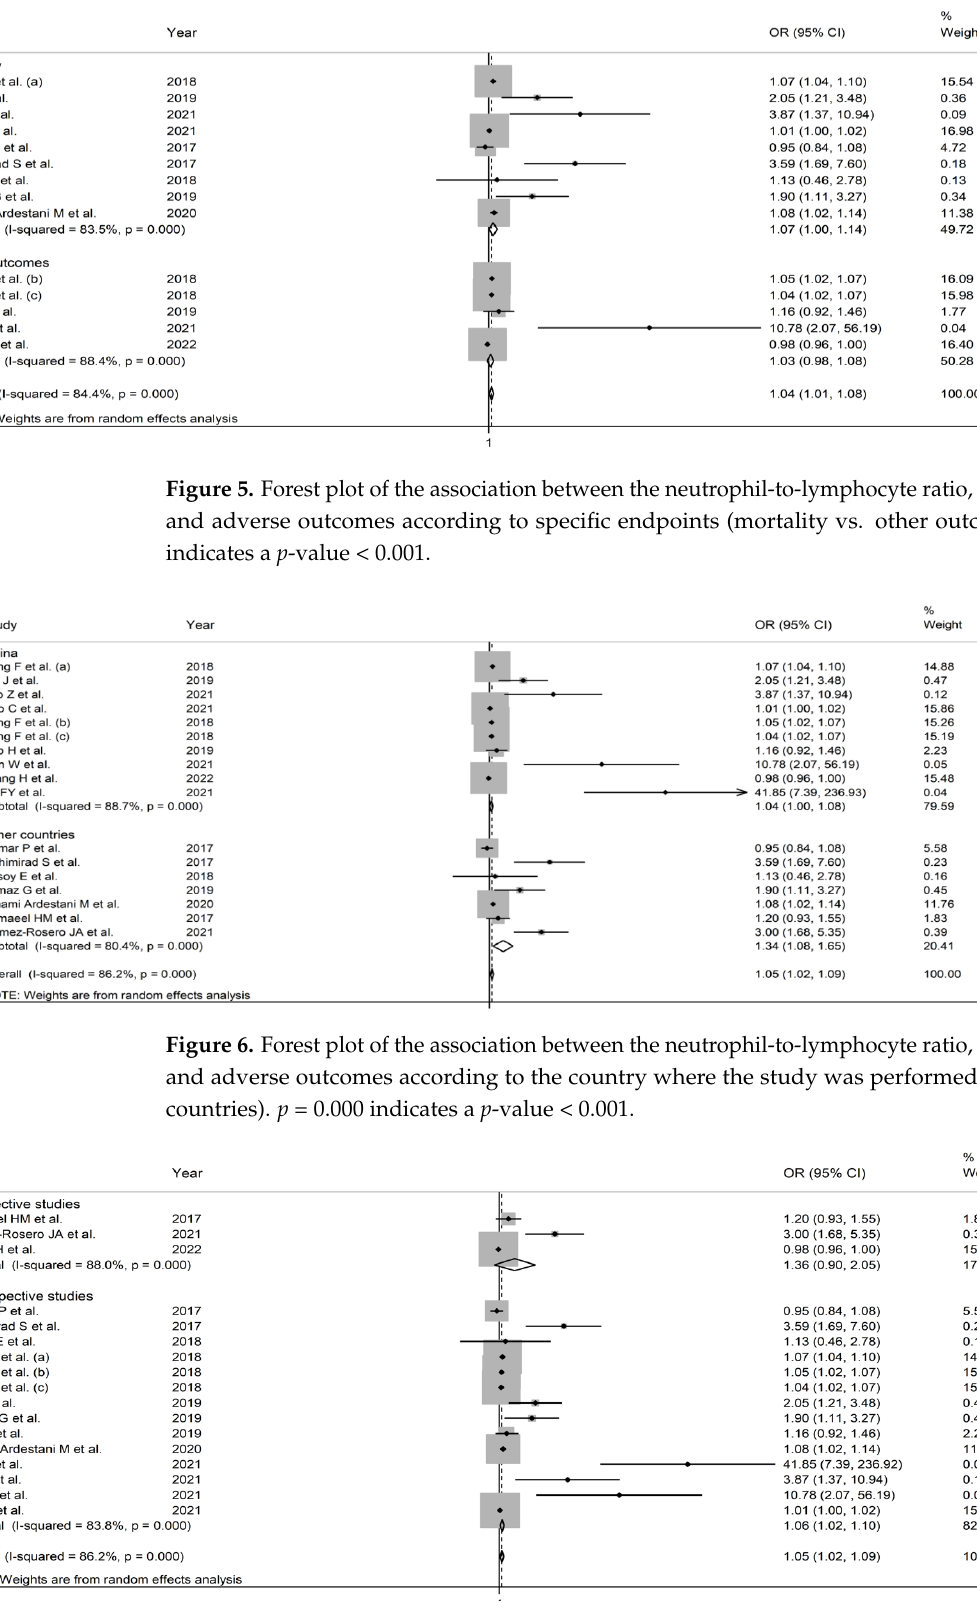
Figure 7. Forest plot of the association between the neutrophil-to-lymphocyte ratio, using odds ratios, and adverse outcomes according to study design (prospective vs. retrospective). p = 0.000 indicates a p -value < 0.001.